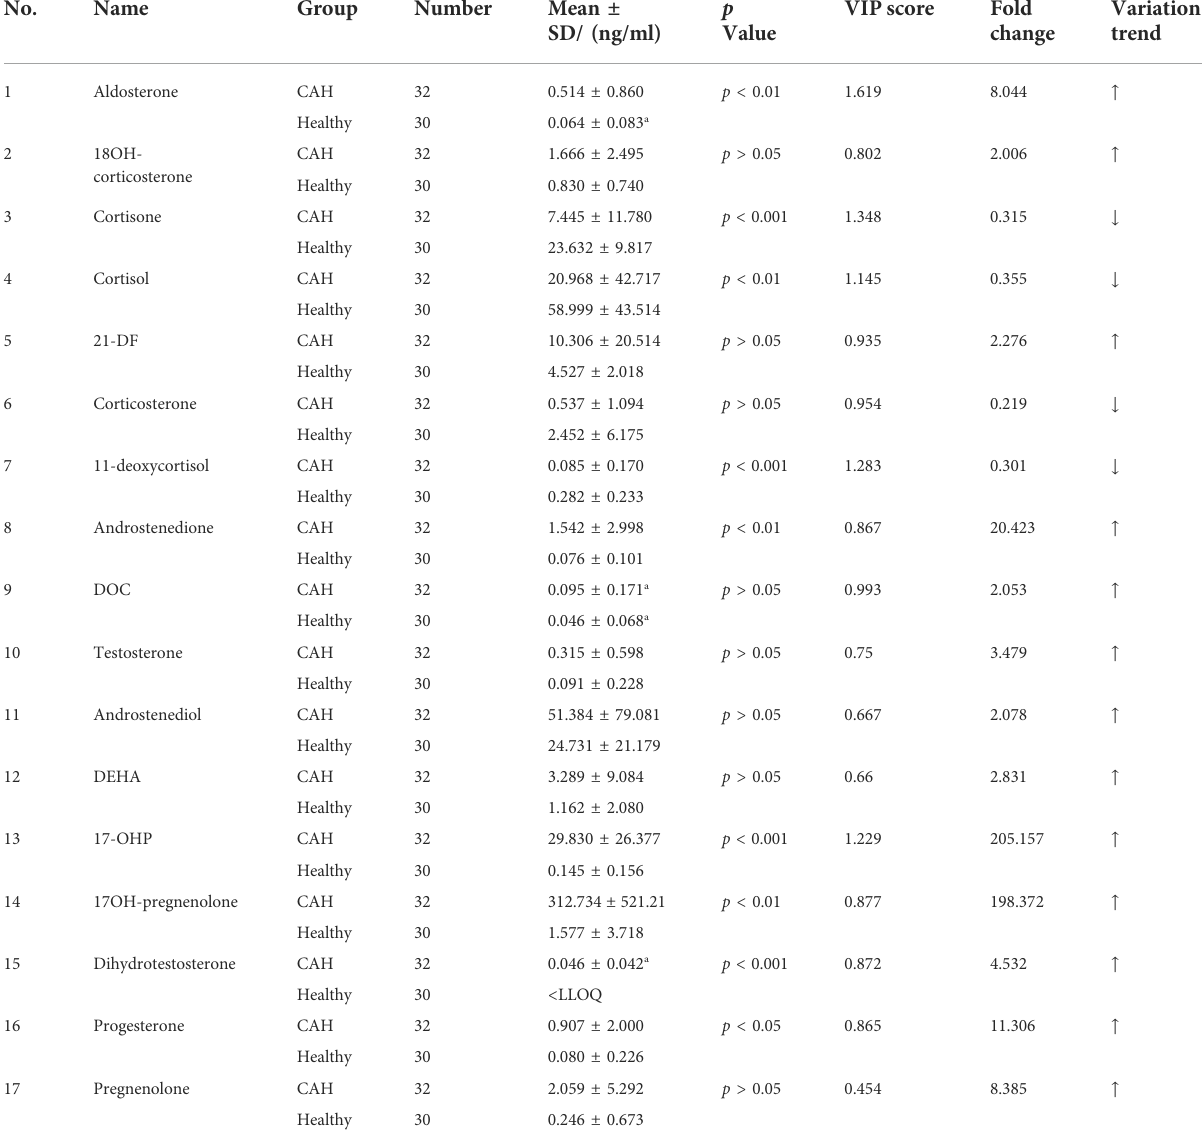
TABLE 6 Statistical table of plasma levels of 17 hormones in CAH group and healthy control group (ng/ml).